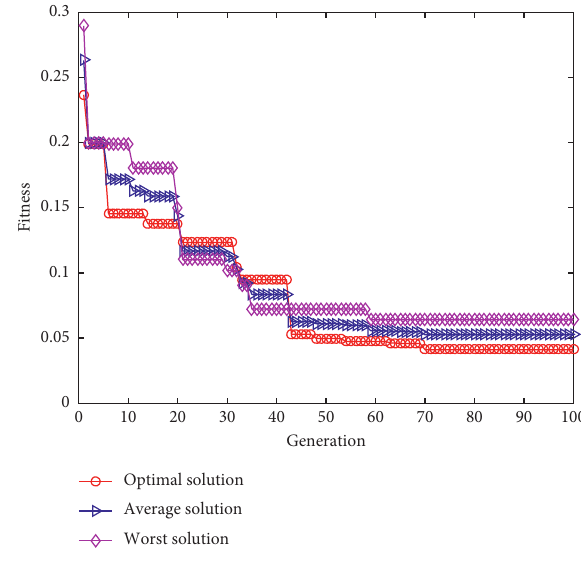
Figure 11: Performance curves of three algorithms. Figure 13: MAC matrix of PSO.